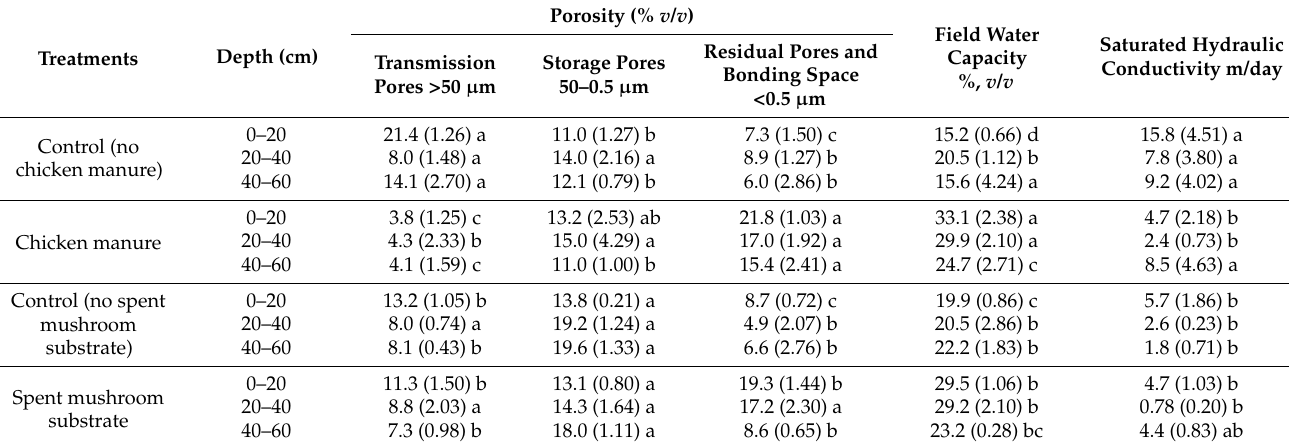
Table 3. Pore size distribution, field water capacity, and saturated hydraulic conductivities of the control and chicken manure- and spent mushroom substrate-amended soils at depths of 0–20, 20–40, and 40–60 cm. Standard deviations are shown in brackets. Means with different letters denote significant differences between the control and treatments at the same depth at the 5% level by the LSD